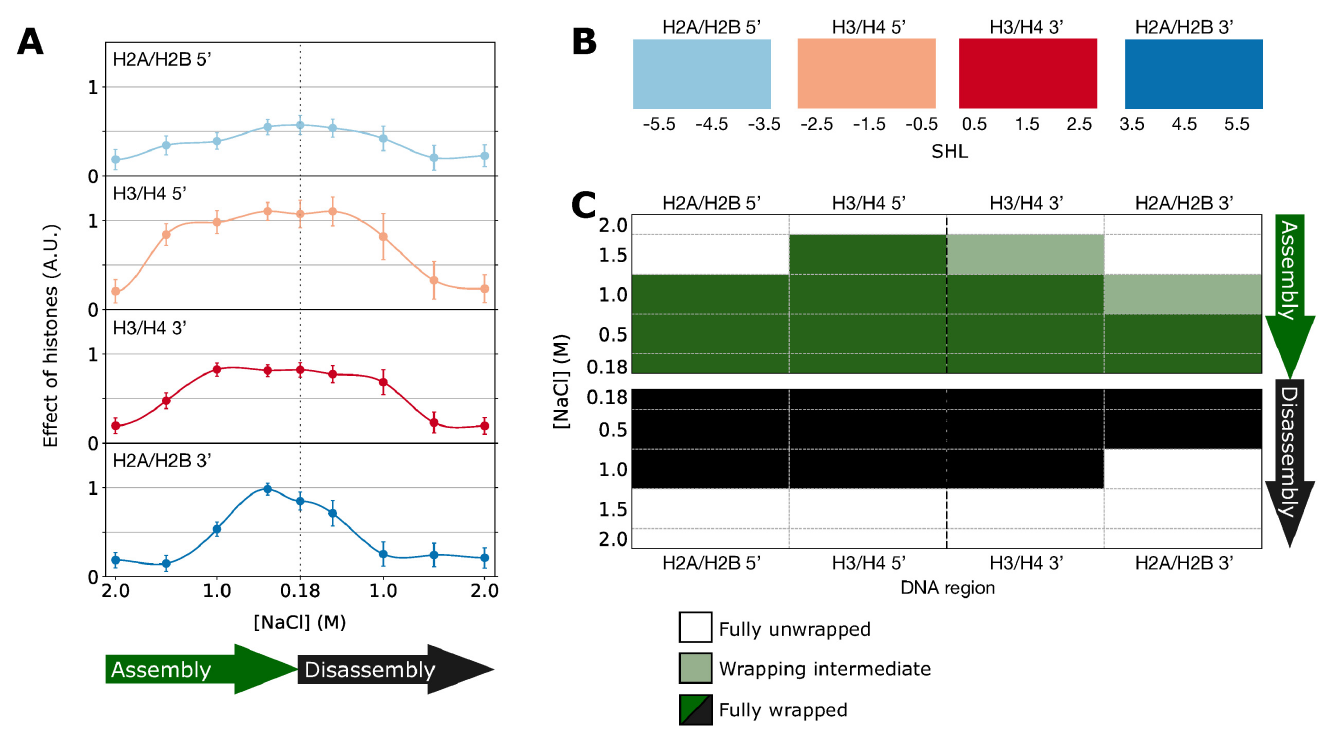
Fig 6. Effect of histones on DNA regions interacting with histone dimers in the fully wrapped NCP. A : Effect of histones as calculated by summing |log2(IR)| over the DNA regions interacting with the histone dimers in the complete nucleosome. Error bars are 1.5 times standard error, such that no overlap between the error bars indicates significant differences (with circa p < 0.05). B: schematic representation of the DNA regions that are associated with the histone dimers in the complete nucleosome. C : Statistical analysis of the traces in A interpreted as the behaviour of each region at each salt concentration, classified as either fully unwrapped, fully wrapped or intermediate (see Materials and Methods). The ordinate shows salt concentration and the abscissa is detailed in B . The top half of the figure (green) refers to assembly and the lower part (black) to disassembly.